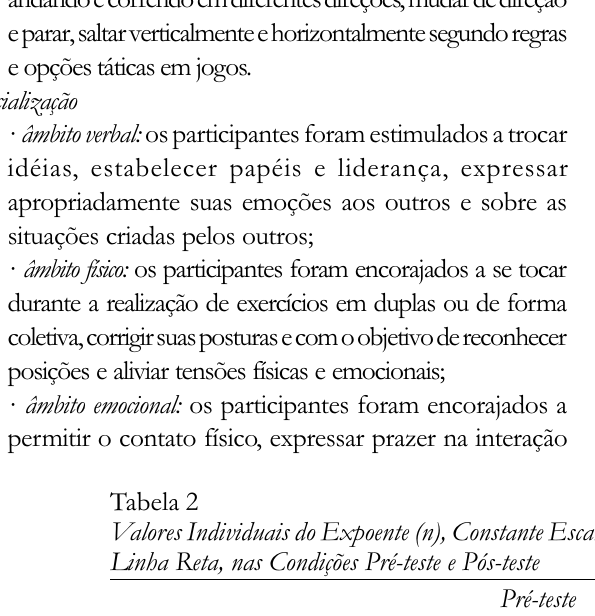
Na Figura 3 estªo ilustrados alguns ambientes do programa. Resultados